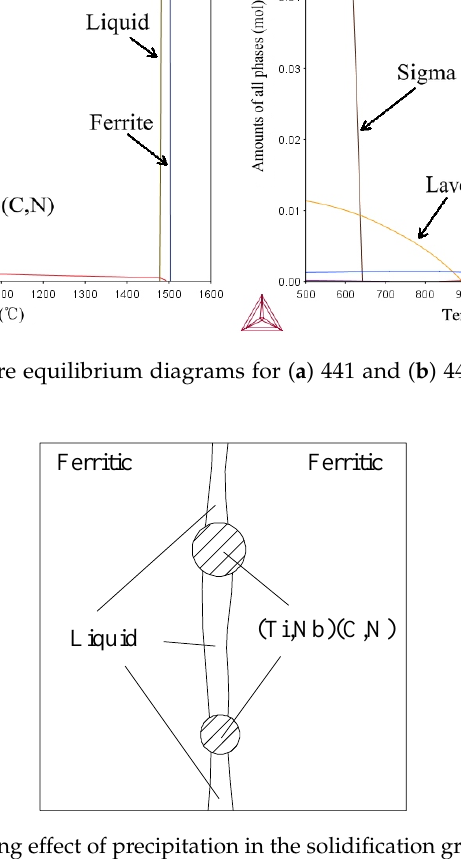
Figure 8. Pinning effect of precipitation in the solidification grain boundary.